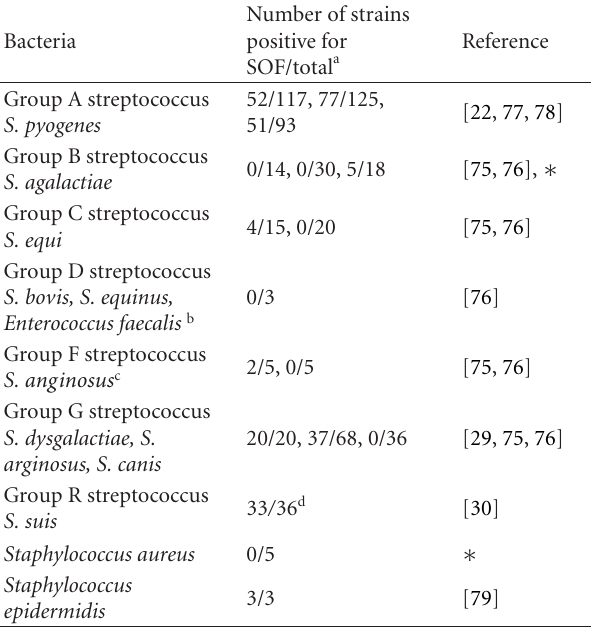
Table 2: Prevalence of SOF among various bacteria. Table 3: Distribution of SOF among M protein serotypes of S. pyogenes